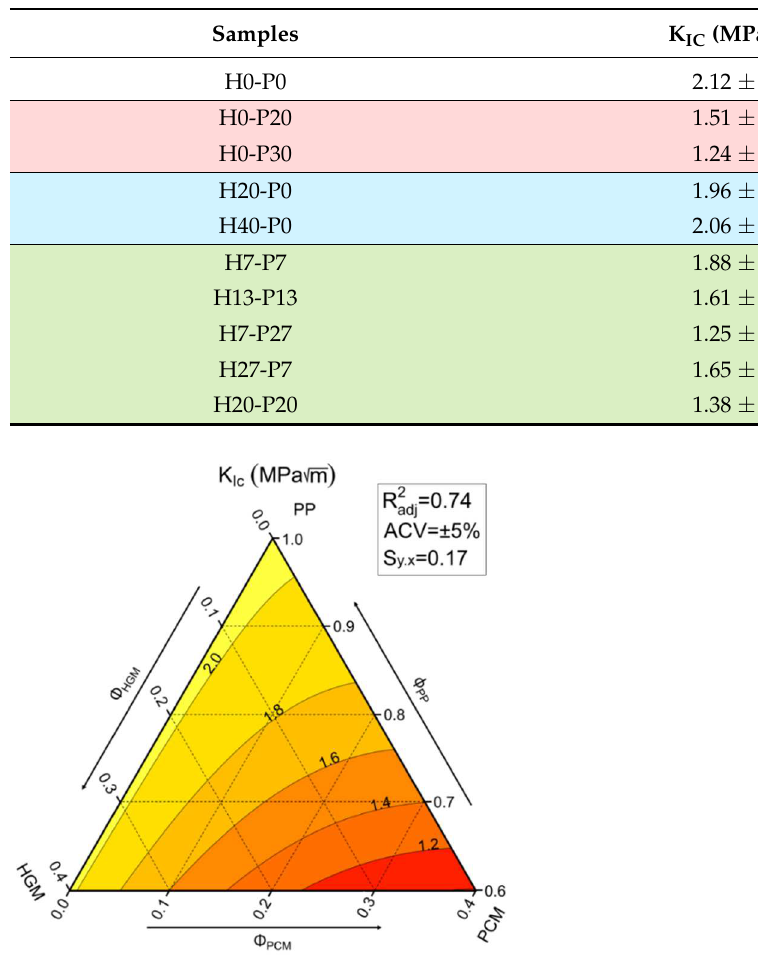
Table 7. K IC results of the prepared foams.